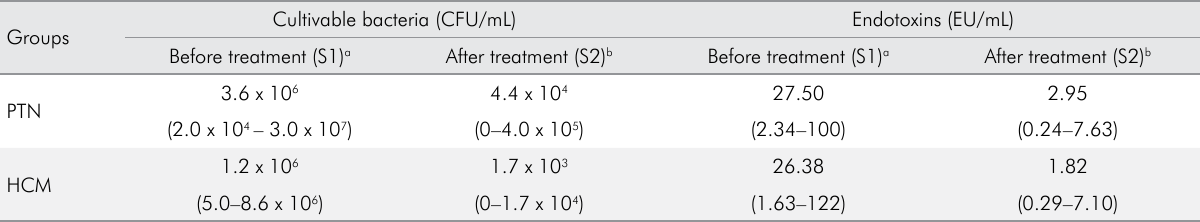
Table 2. Effectiveness of PTN and HCM for the removal of cultivable bacteria (CFU/mL) and endotoxins (EU/mL) from primarily infected root